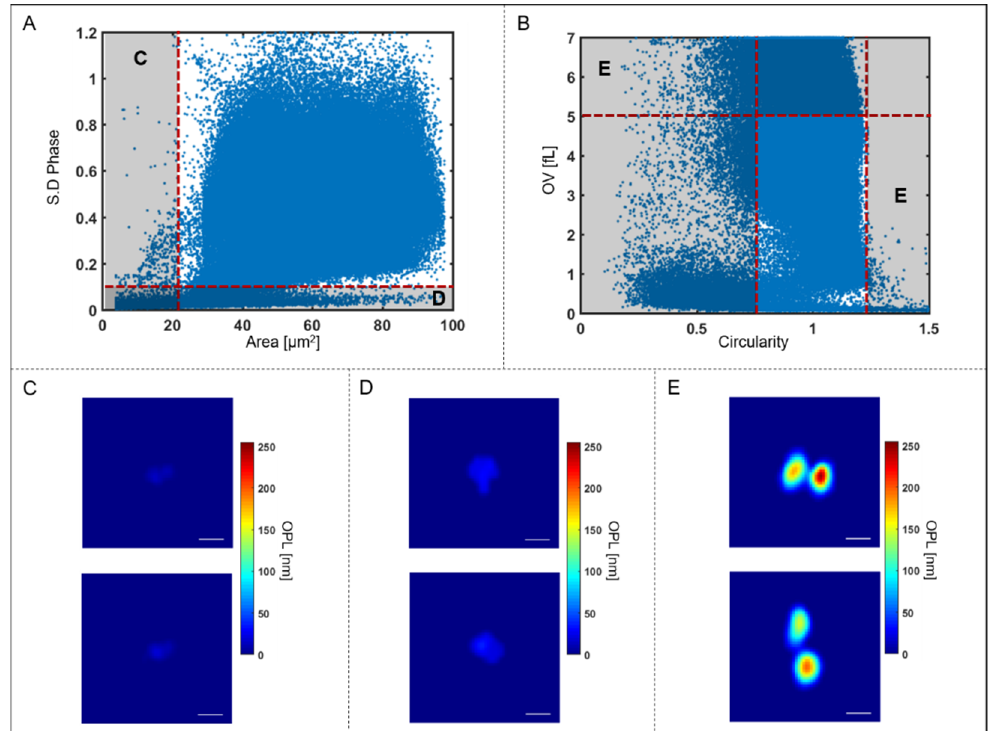
Figure 4. Illustration of outlier rejection based on QPI parameters. ( A ) Scatter plot showing standard deviation of phase and area of all objects imaged in a typical flow sequence before quality check. ( B ) Scatter plot showing OV and circularity of all objects in the sequence. Segmented objects with area < 21 µm 2 , (ex. ( C )), shown on the scatter plot ( A ) by the red vertical dotted line and objects with standard deviation < 0.09, (ex. ( D )), shown by the red horizontal dotted line are excluded from further analysis. Multiple-connected cells, i.e., clumps with OV > 5 fL and circularity <0.85 or >1.23, ex. ( E ), shown on the scatter plot in ( B ) by the red dotted lines are also excluded from further analysis. Scale bar = 5 µm.